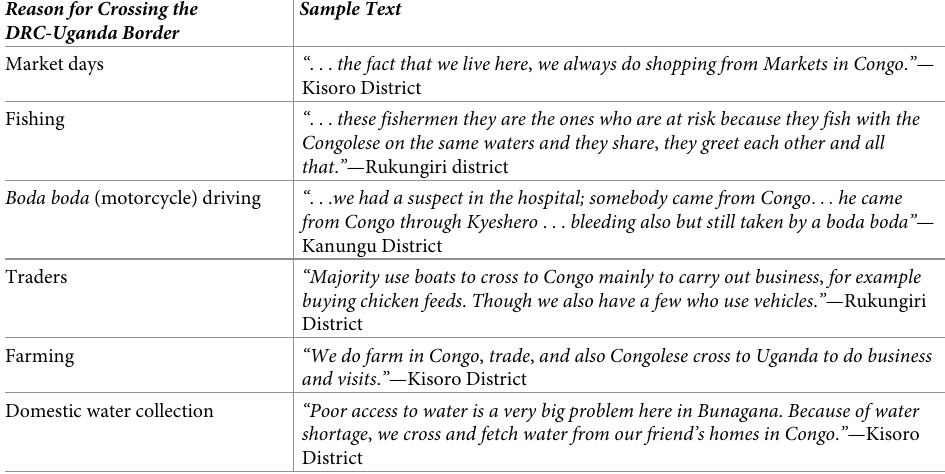
Table 3. Movement across borders: Reported reasons for cross-border movement in